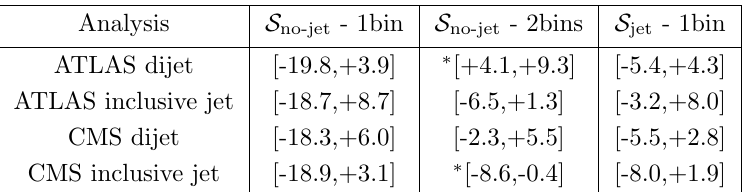
Table 3 . 95% CL constraints on the Z parameter. Di(cid:11)erent rows correspond to the four exper- imental searches of table 2, while di(cid:11)erent columns correspond to di(cid:11)erent PDF sets or di(cid:11)erent numbers of rapidity bins included in the (cid:12)t. The entries marked with ‘*’ are those for which the (cid:12)t excludes the SM (Z = 0) at 95%